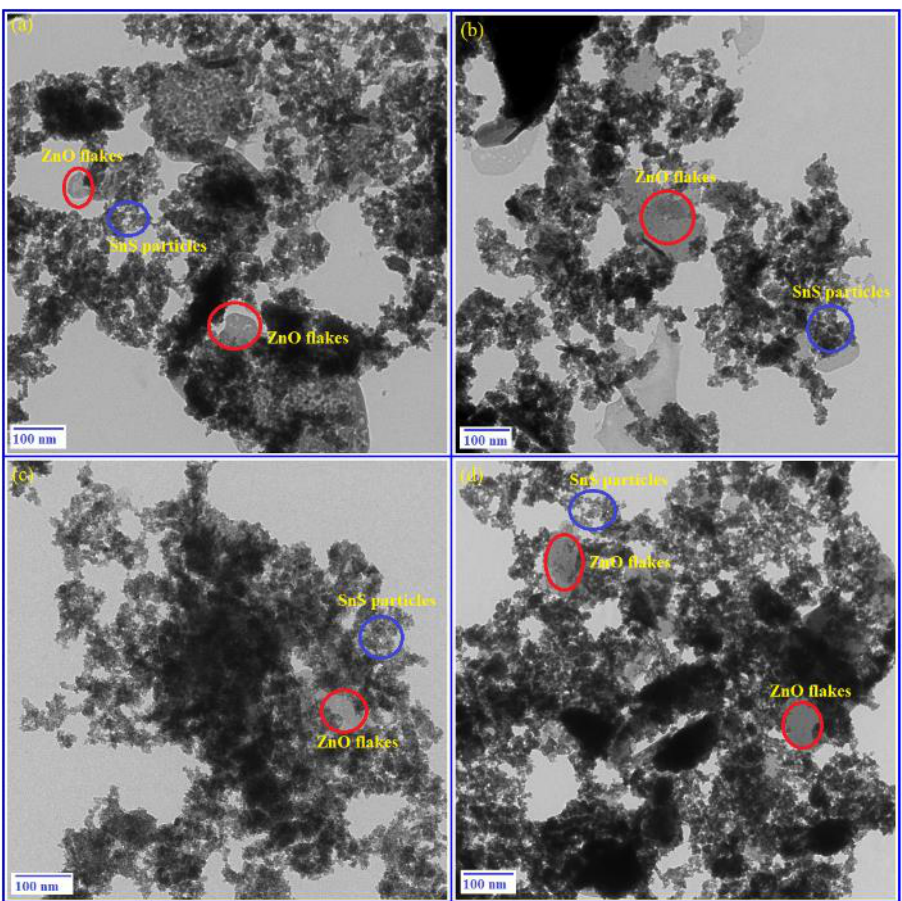
Figure 2. TEM images of ( a ) ZS, ( b ) ZS-C1, ( c ) ZS-C3, and ( d ) ZS-C5 nanocomposites.